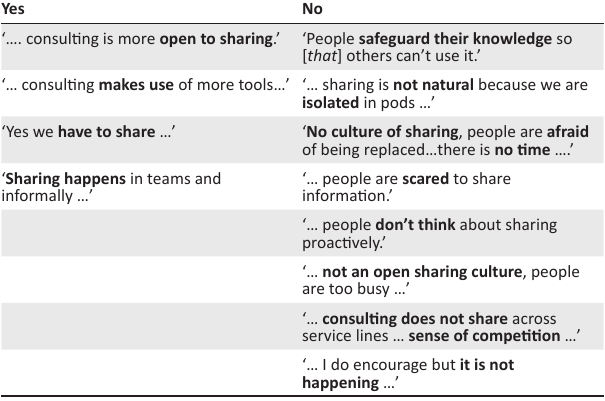
TABLE 1: Verbatim feedback from interviews for culture of knowledge sharing (emphasis added). Yes No